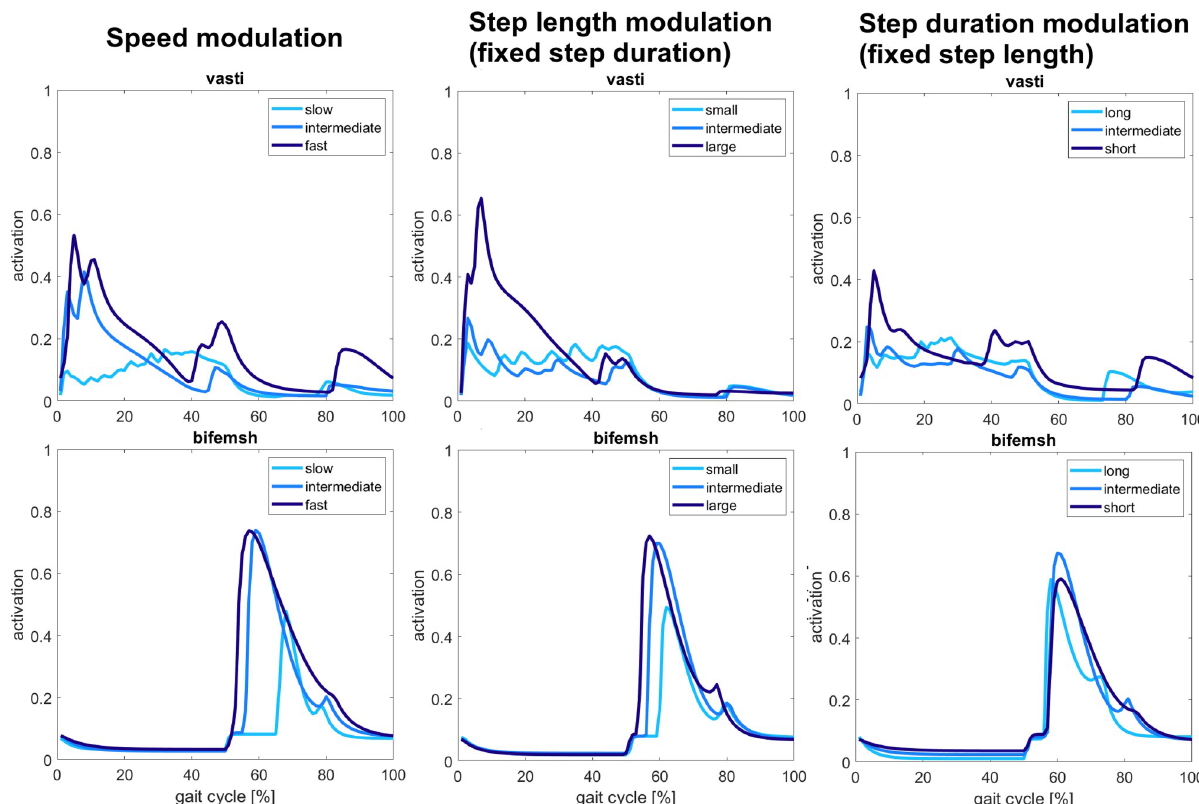
Fig 9. Knee muscles activity. Higher activation is observed for both the vasti and biceps femoris short head muscles at fast speeds and large step